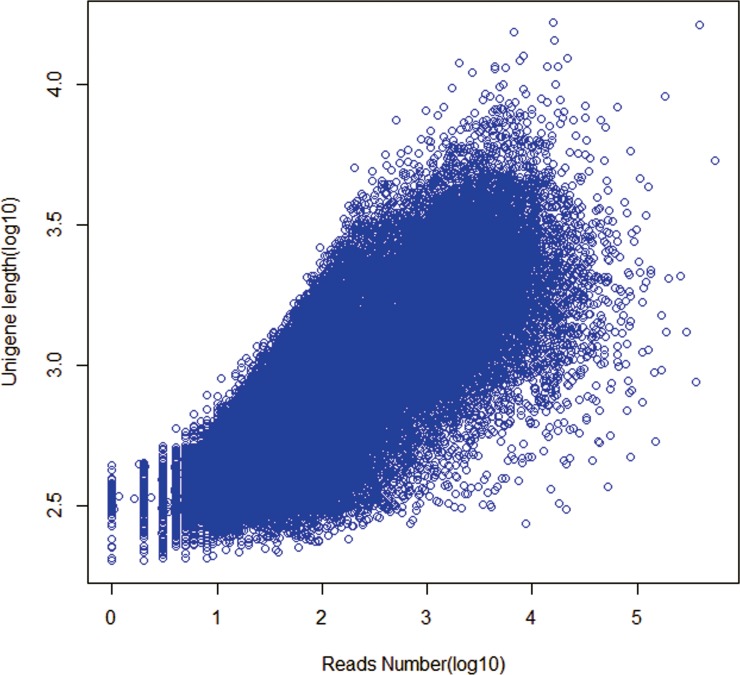
Dependence of unigene lengths on the number of reads assembled into that unigenes.